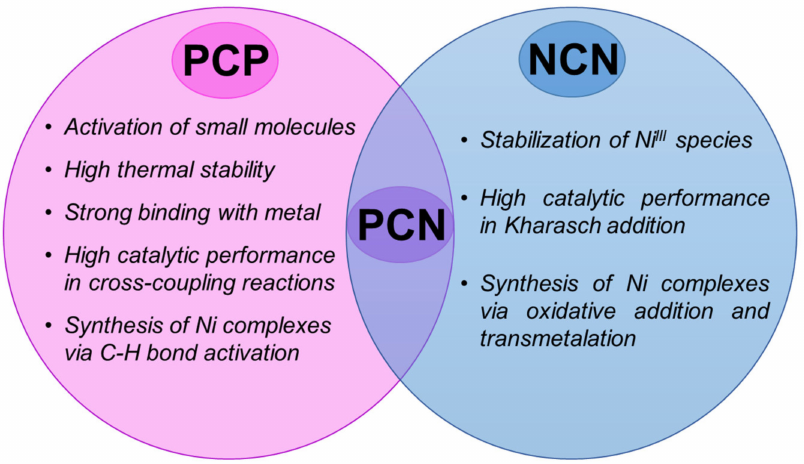
Figure 2. Properties of the nickel complexes formed by different types of pincer ligands.